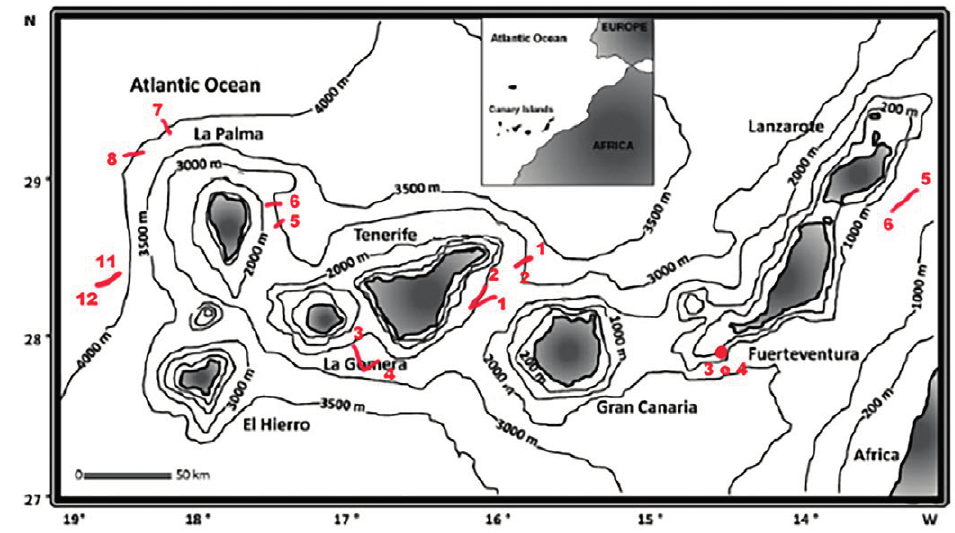
Fig. 1. – Map of the Canary Islands showing set locations off the islands of Tenerife, La Gomera, La Palma, Fuerteventura and El